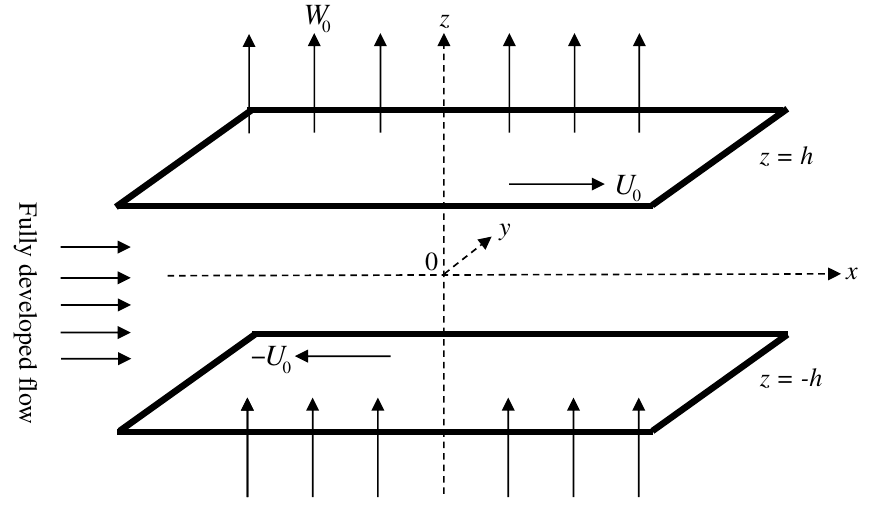
Figure 1. Schematic illustration of the physical